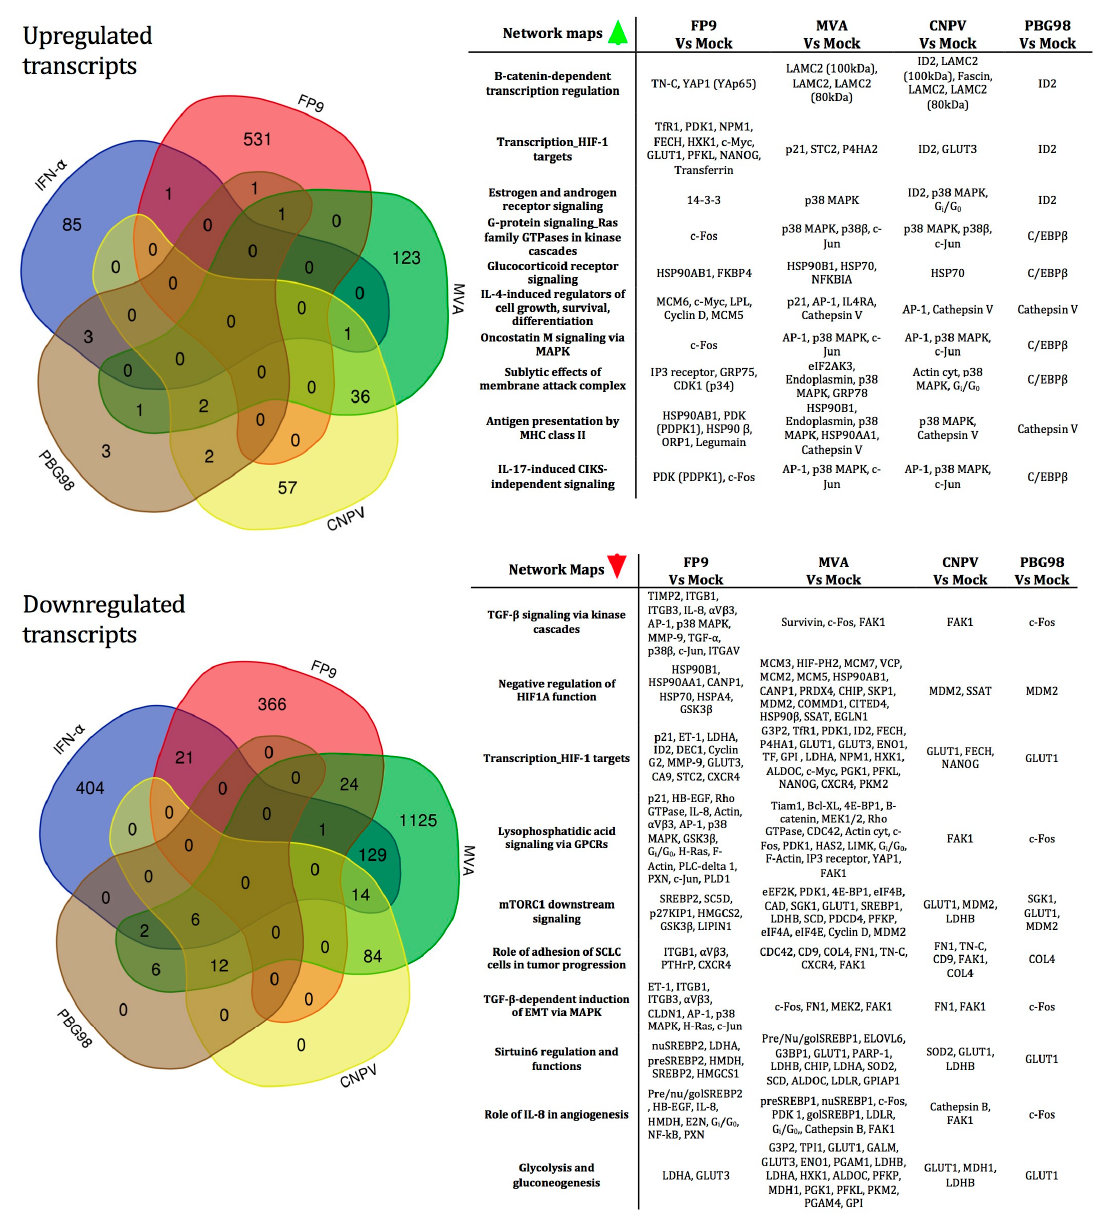
Figure 5. Left: Venn diagrams showing the distribution of unique and shared up- (top left panel) and down-regulated (lower left panel) transcripts in virus-infected cESC. The numbers in the intersections of each circle represent the number of transcripts common to each condition (FDR ≤ 0.05 and fold change ≥± 1.5). Right: Top 10 statistically significant MetaCore GeneGO network pathway maps associated with up-regulated (top right table) and down-regulated transcripts in the comparison between virus-infected and mock-infected samples (Full enrichment analysis is described in Supplementary file 2).